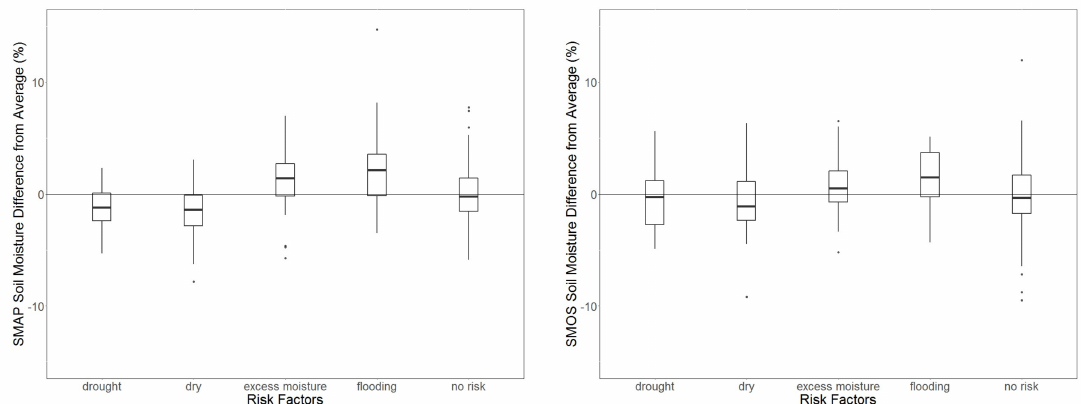
Figure 6. Soil Moisture difference from the long-term average (SMDA) from a SMAP-SMOS time series ( Left ) and a SMOS-only time series ( Right ) for different risk conditions as evaluated from expert reports. Data are aggregated to monthly time